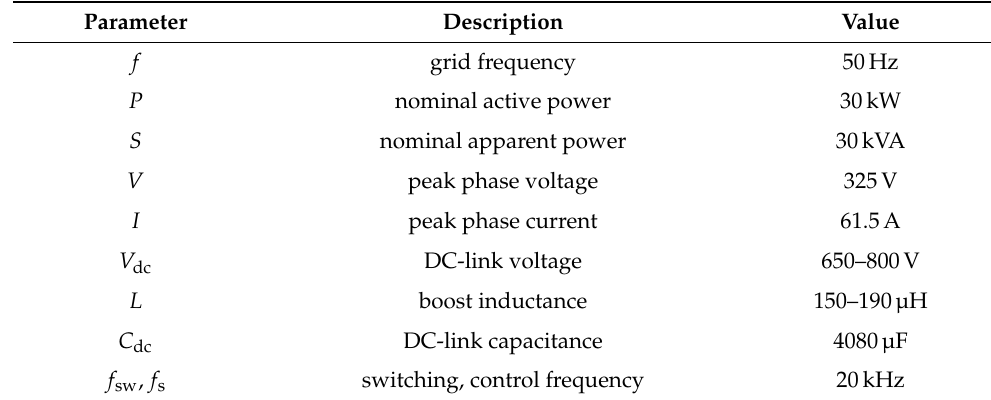
Table 1. Three-level unidirectional T-type rectifier specifications and nominal operating conditions.